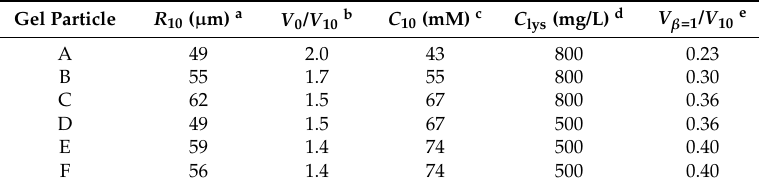
Table 1. Description of the investigated lysozyme–microgel systems.